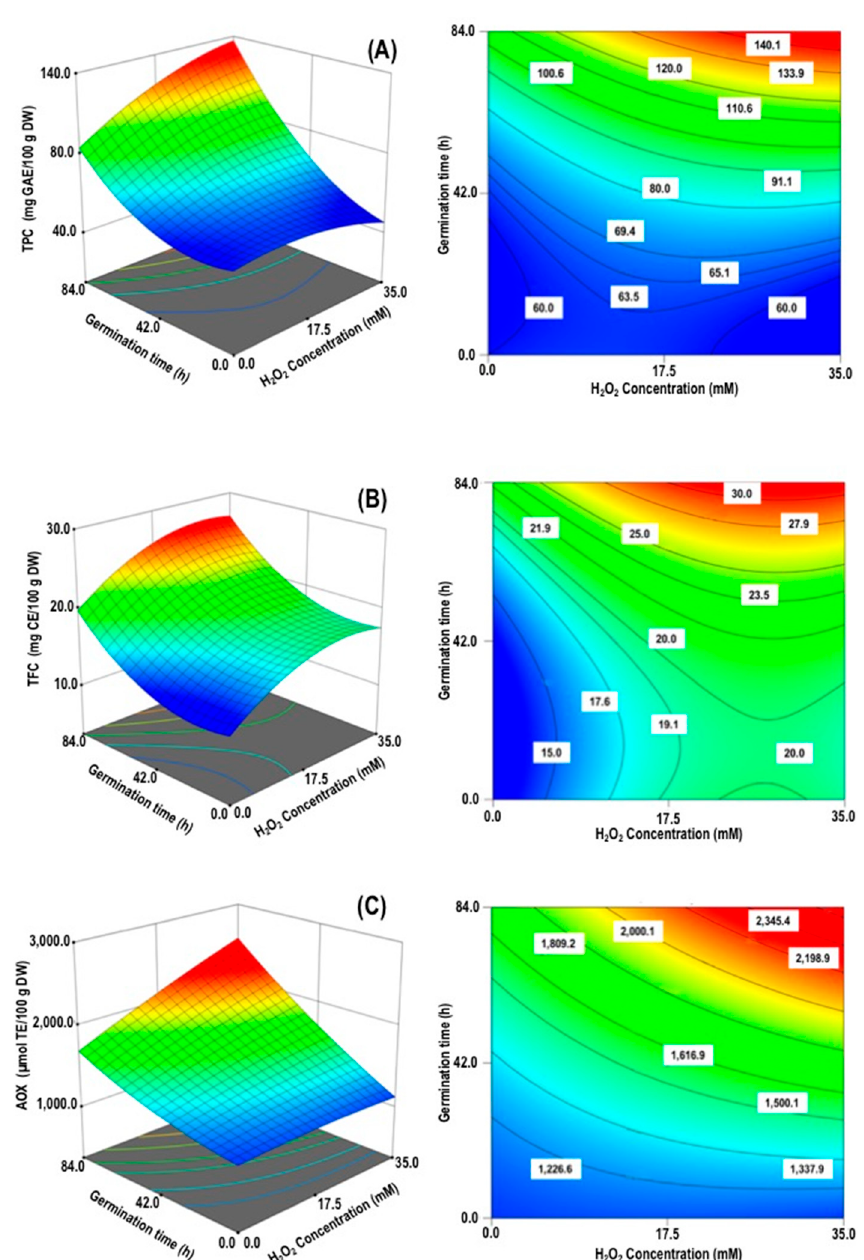
Figure 2. Response surface and contour plots for the effect of the germination condition (H 2 O 2 concentration and germination time) on the responses variables ( A ) Total phenolic content (TPC); ( B ) Total flavonoids content (TFC); and ( C ) Antioxidant activity (AOX) of chickpea sprouts.